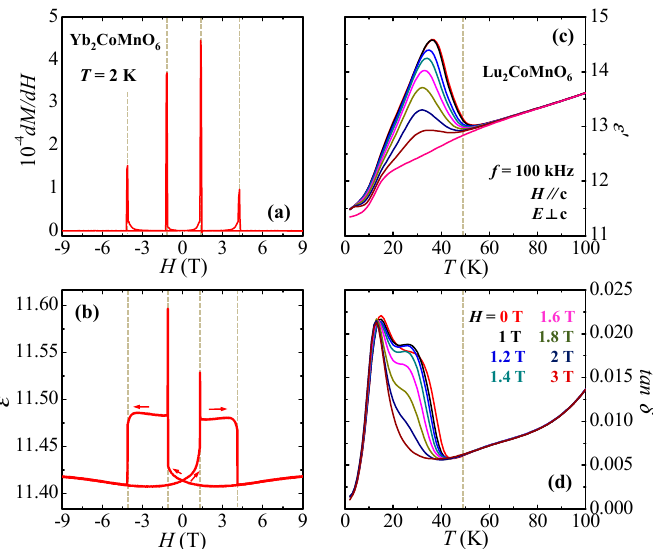
Figure 5. Isothermal magnetization along and perpendicular to the c axis measured at 2 K after ZFC for YCMO ( a , b ) and LCMO ( c , d ).